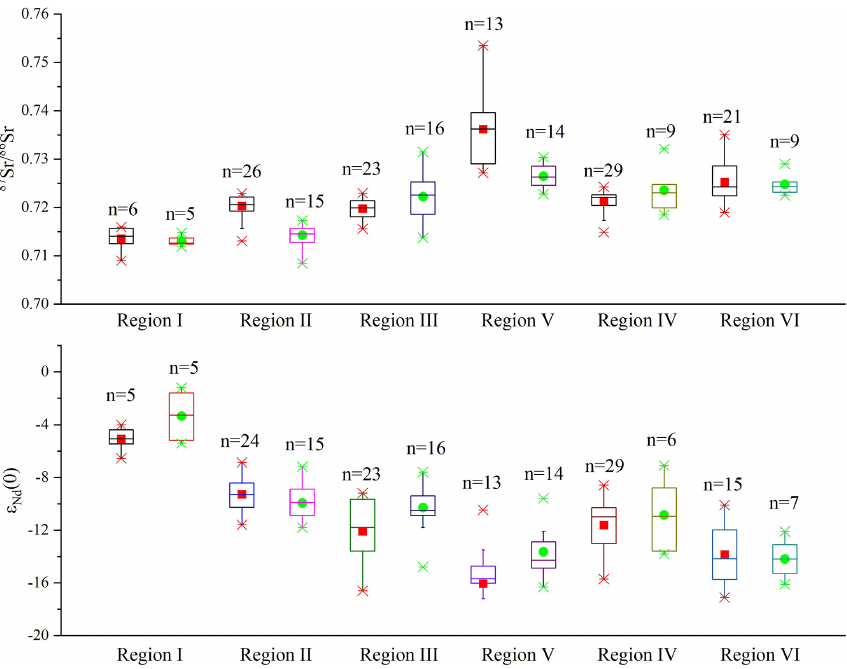
Figure 3. Box plot of the Sr–Nd isotope signatures of third pole PSAs and snow samples. Samples are located in each PSA based on the data from Table 2 (the number of samples for each subregion are presented, n> 5). The horizontal line within the box is the median, and the squares are the mean Sr–Nd values (red rectangles for sand or soil samples and green solid circles for snow samples). The interquartile range is represented by the lower and upper boundaries of the boxes, and whiskers indicate confidence intervals of 1.5 times the interquartile